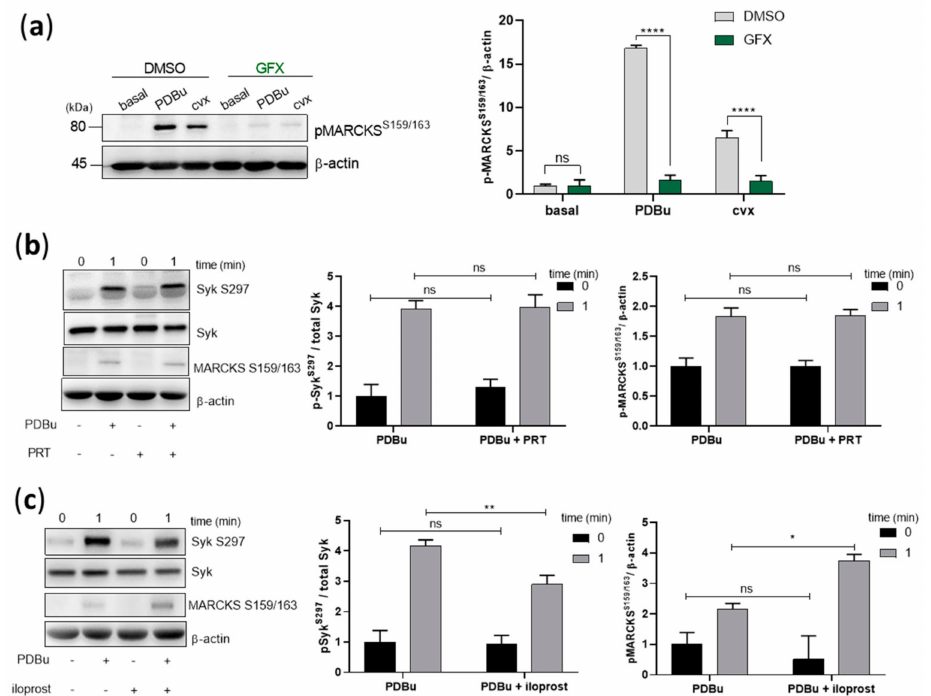
Figure 6. PKC activation induces Syk S297 phosphorylation, which is independent from Syk and only partially inhibited by PKA. Washed human platelets were pre-incubated with DMSO (vehicle control) or with pan-PKC inhibitor, GF109203X (5 µ M) at 37 ◦ C for 5 min prior to stimulation with 0.2 µ M PDBu or 50 ng / mL cvx. ( a ) Platelet aggregation was stopped by adding Laemmli bu ff er after 1 min of stimulation under stirring conditions. MARCKS S159 / 163 phosphorylation was analyzed by